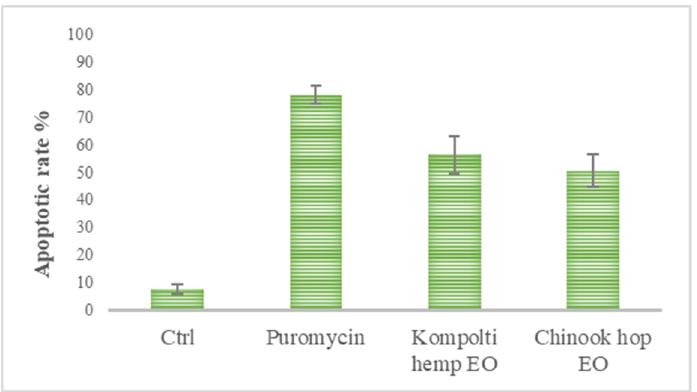
Figure 5. Bar graph of apoptotic rates obtained from the sum of the percentages of EA and LA cells in flow cytometric analysis using AnnexinV-FITC/PI staining. The values are expressed as % ± standard error mean (sem).